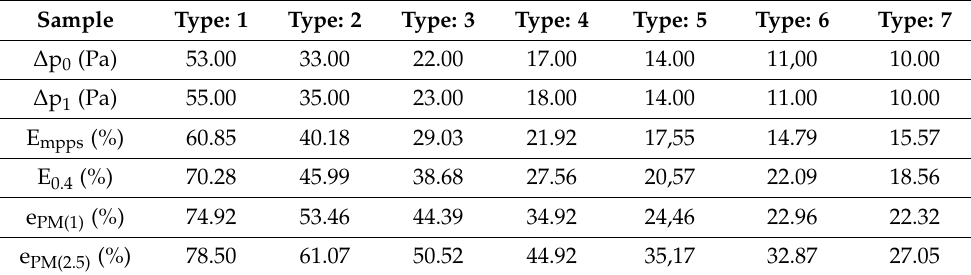
Table 5. Results of modified melt-blown filtration